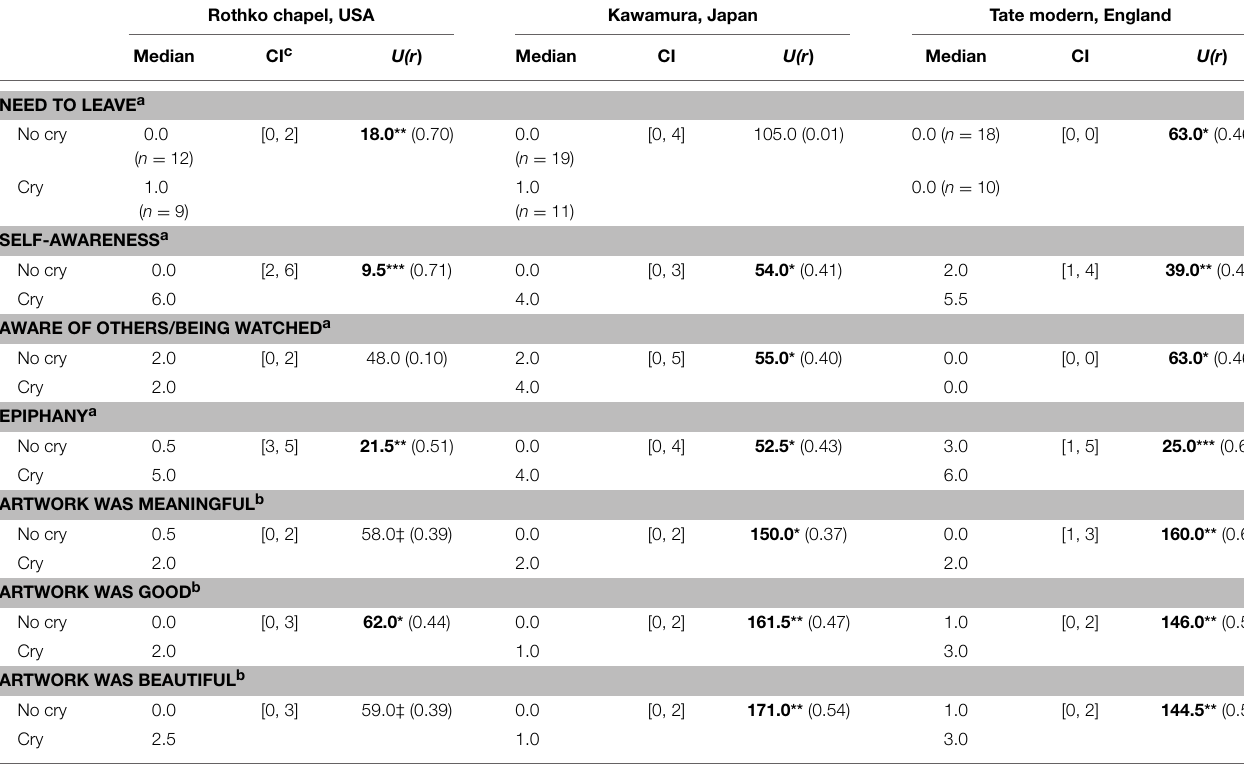
TABLE 5 | Comparison of reported experiential factors and artwork evaluations between viewers who do or do not “feel like crying” in three encounters with museum